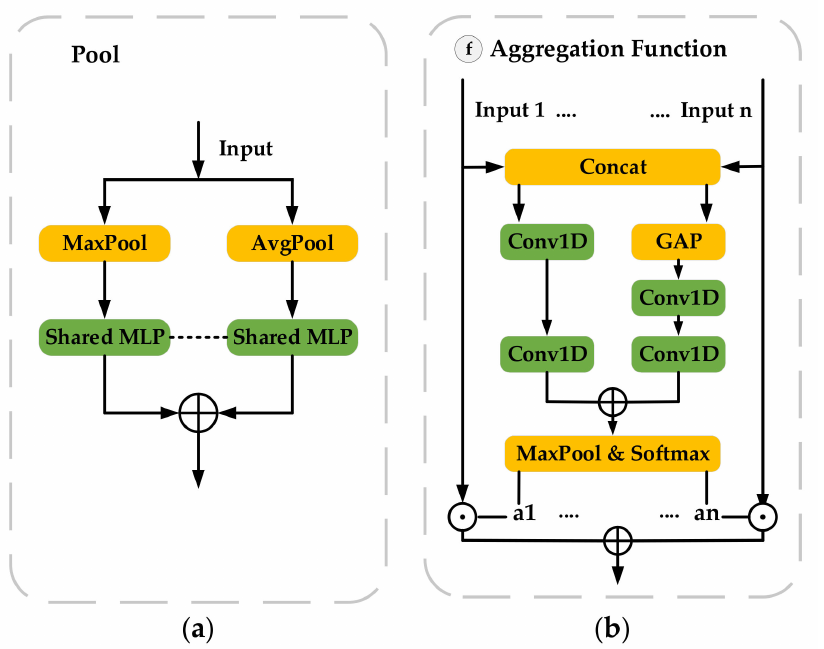
Figure 6. Details of the down-sample operation and aggregation function: ( a ) Architecture of Pool; ( b ) Architecture of Aggregation